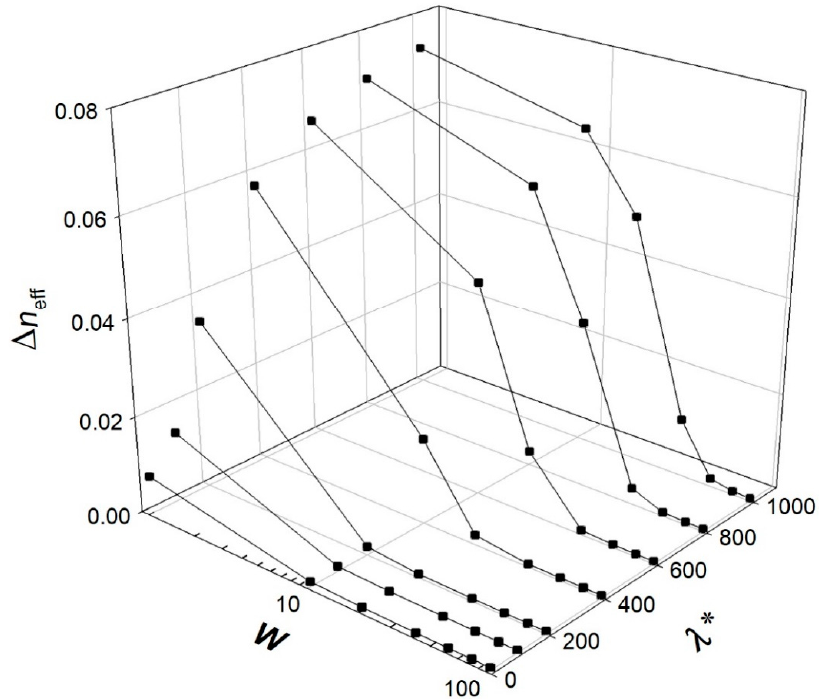
Figure 8. Birefringence at steady state versus dimensionless anchoring energy for different ranges of dimensionless surface viscosity parameter.